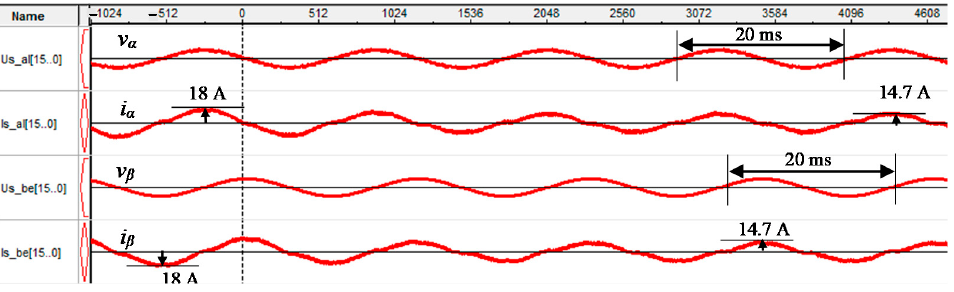
Figure 16. Phase modulation of grid voltages (from − 30° to +30° within 100 ms interval) at constant active component 0.7 P N .